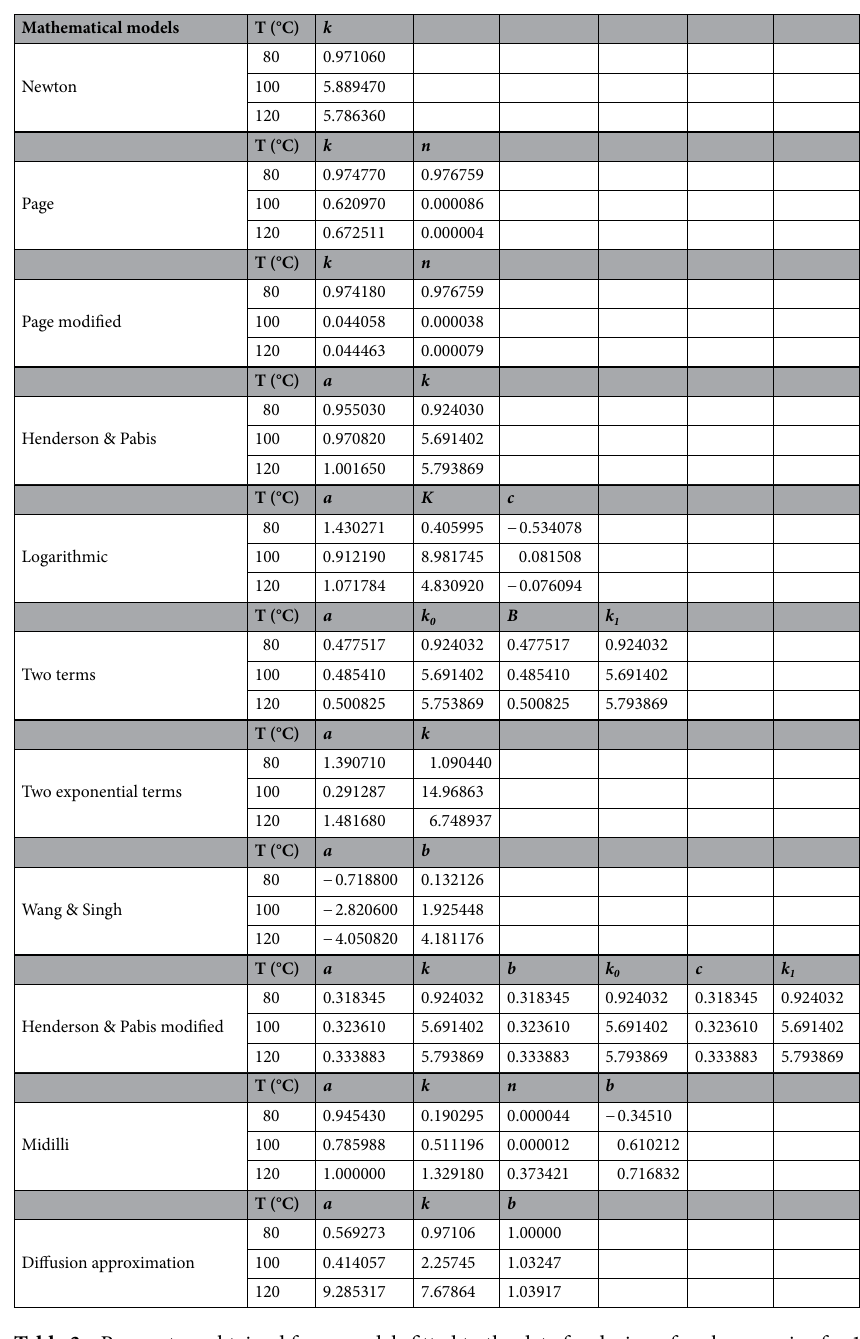
Table 3. Parameters obtained from models fitted to the data for drying of soybean grains for 18% (d.b.) of initial moisture